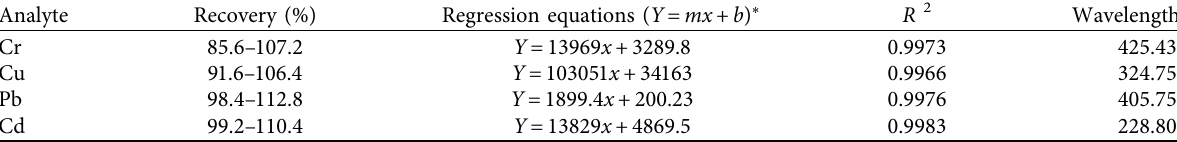
Table 2: Recovery test results and calibration curve equations for the determination of heavy metals in selected cereals.